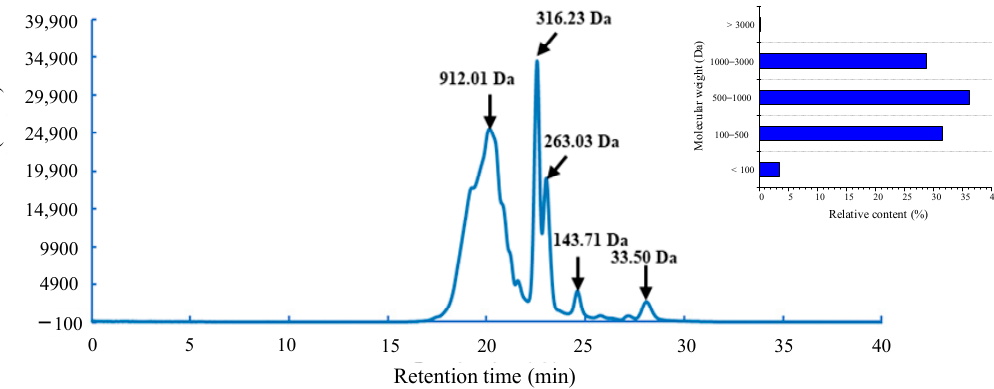
Figure 2. Molecular weight distribution of G. livida protein hydrolysate prepared by neutral protease for 1 h hydrolysis.